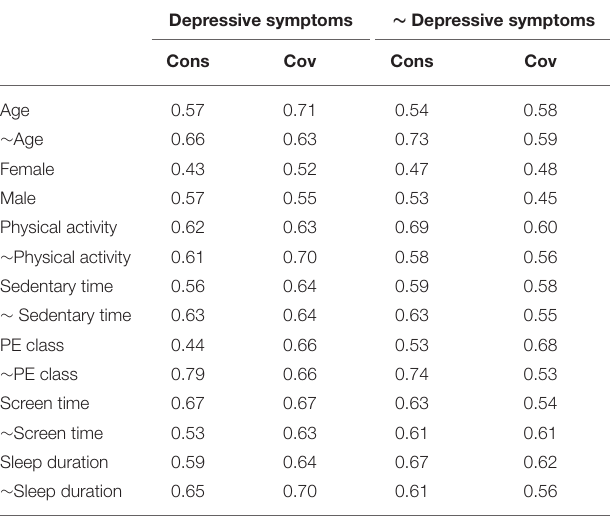
TABLE 3 | Necessity analysis for depressive symptoms.